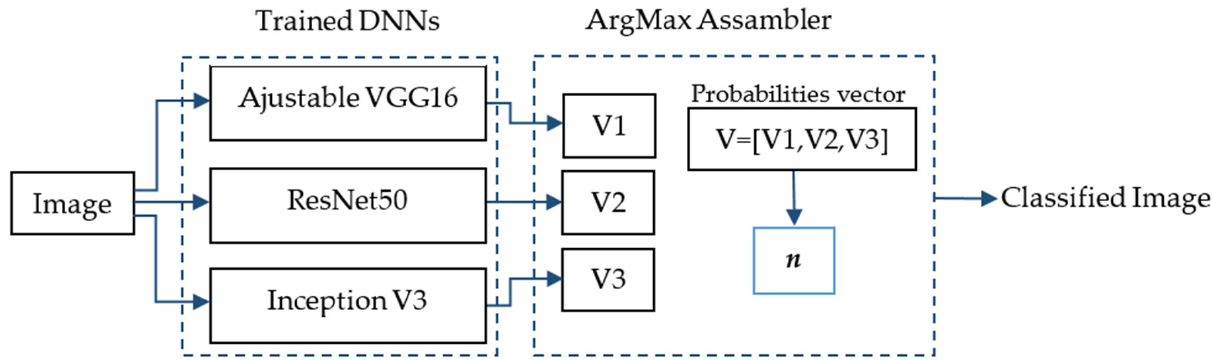
Figure 3. ArgMax ensemble configuration for the skin lesion